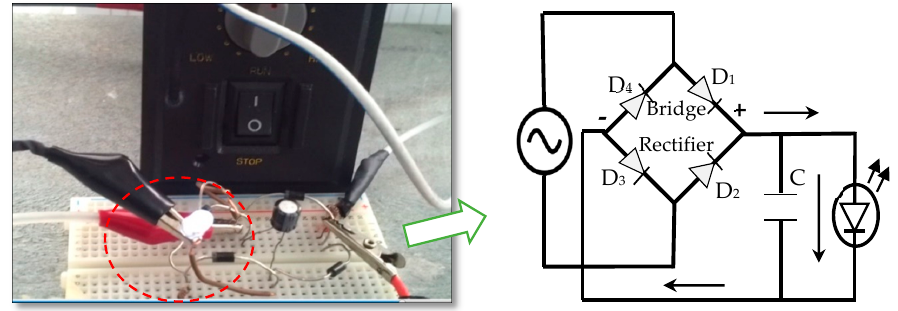
Figure 9. Flashing up light emitting diode (LED) (5 mm).